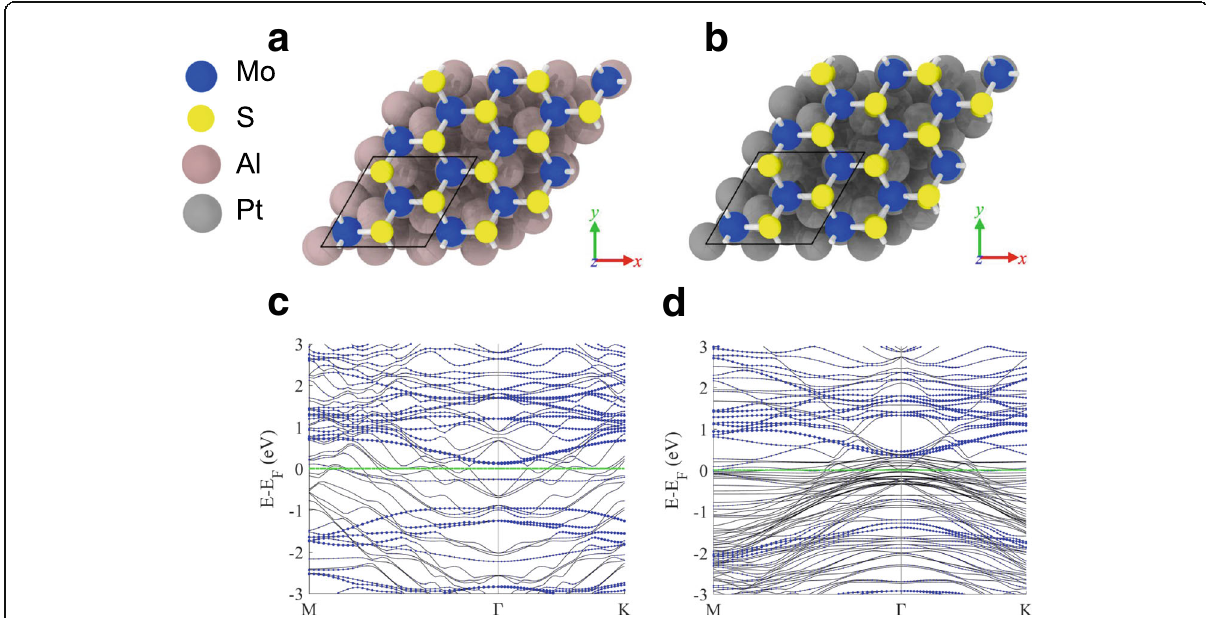
Fig. 3 a , b The 3D models of MoS 2 on Al and Pt substrates, which were used in DFT calculations. c , d The band structures of these models. Green lines indicate the Fermi energy set by taking zero as the work function of the vacuum level. Blue dashes correspond to the energy bands